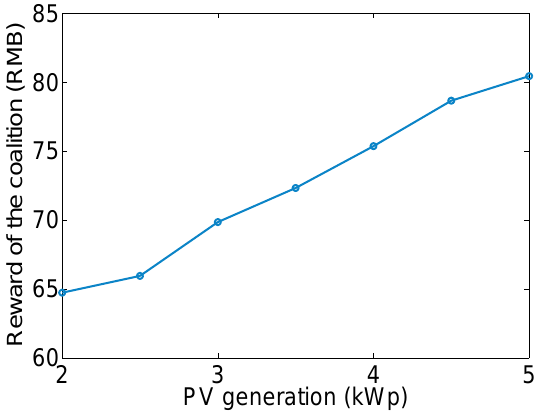
Figure 5. Sensitivity analysis of PV generation.